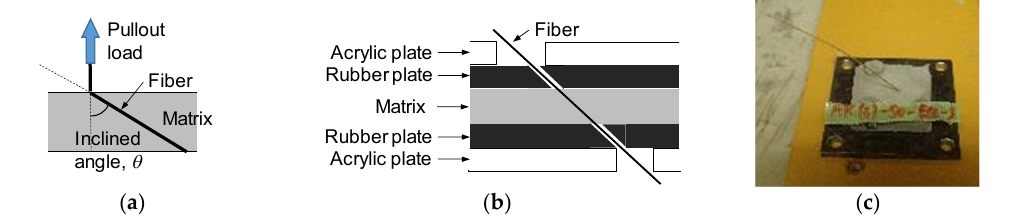
Figure 3. Pullout specimen with inclined fiber: ( a ) Definition of inclined angle; ( b ) Constitute of mold and fixing of fiber; ( c ) Example of specimen with inclined fiber.